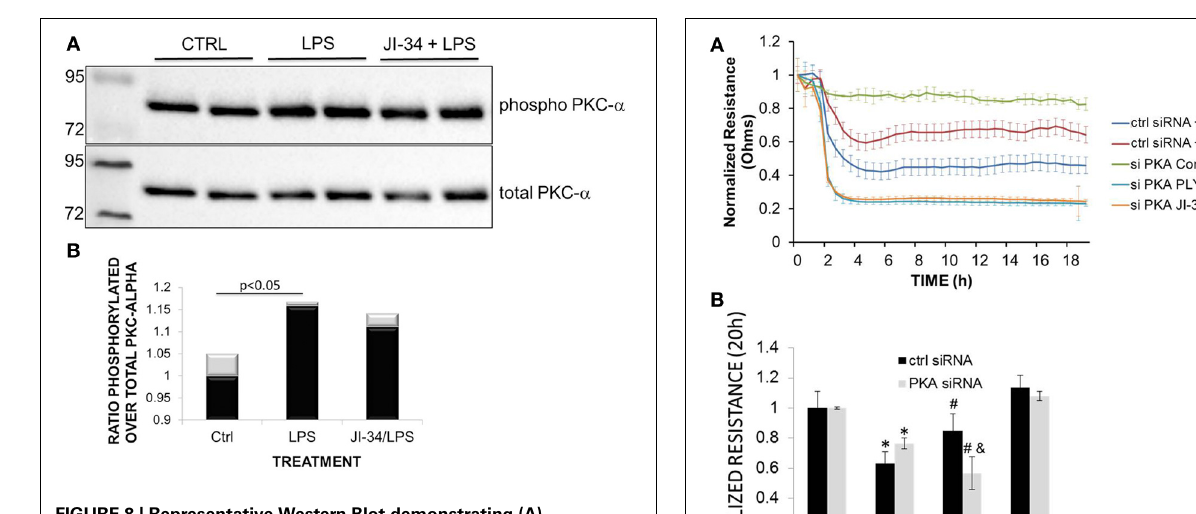
FIGURE 8 | Representative Western Blot demonstrating (A) phosphorylated PKC- α and total PKC- α activity in ctrl, LPS-treated (1 μ g/ml, 1h) and JI-34(1 μ M, 15min)/LPS-treated HL-MVEC. (B) Phosphorylated over total PKC- α ratios. Mean + SD (gray bars) ( n = 3 per group).